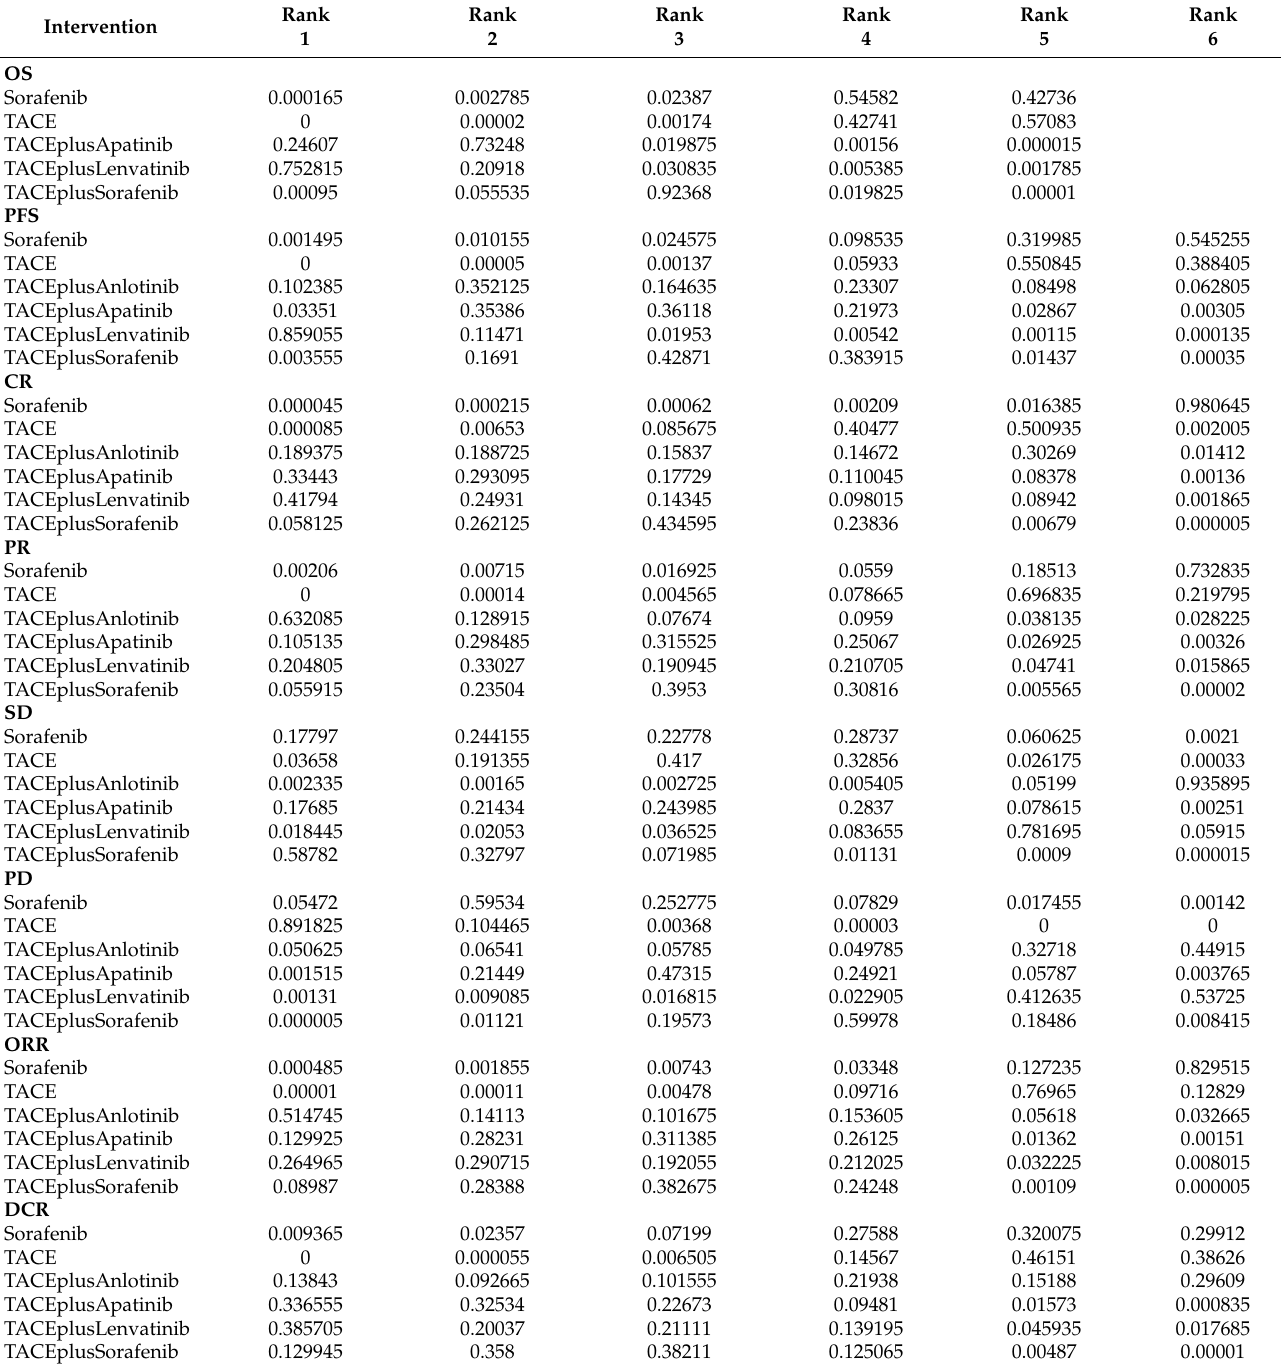
Table 2. Analysis of treatment ranking probability in patients with